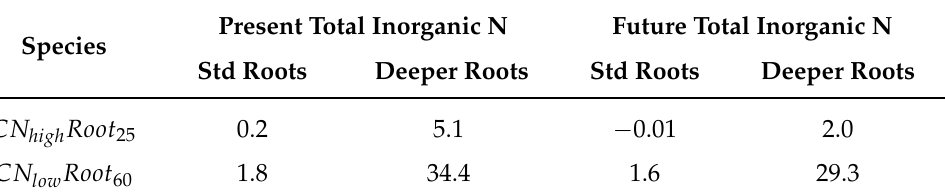
Table 4. Change in plant-available inorganic nitrogen (g[N]m − 2 year − 1 ) derived using Equation (4) from monthly JULES output, taken as 10-year annual averages for present (2000–2010) and future (2090–2100). In all cases, the maximum summer thaw depth is defined using the future simulations (i.e., >1.2 m). The left two columns show the change in available inorganic N using the present-day nitrogen cycle; so, they do not include any simulated change in total inorganic nitrogen as a result of a changing climate. The right two columns use the total inorganic nitrogen simulated for the future time